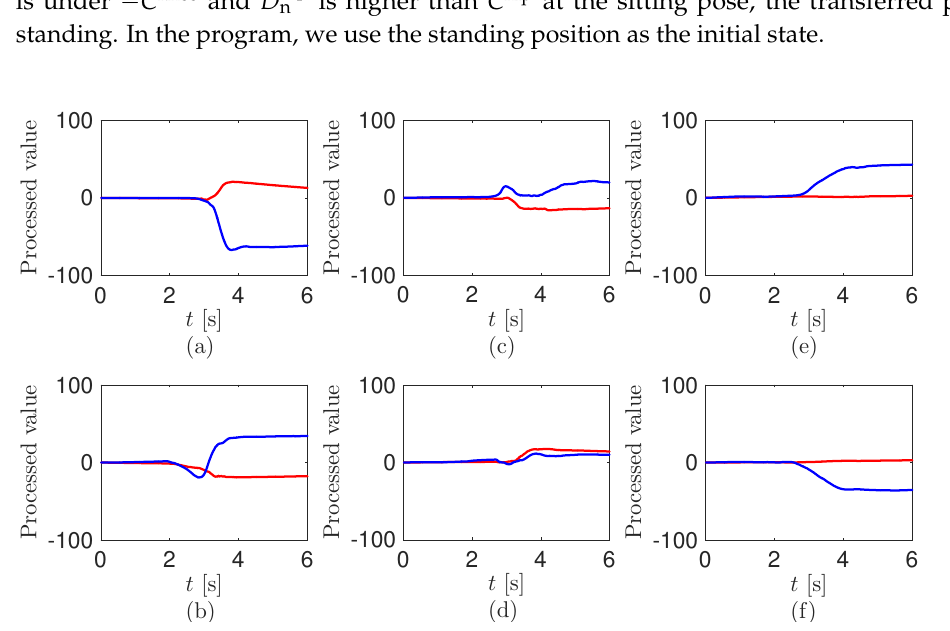
Figure 6. Signal processed values from the sensor outputs at the transition ( a ) from the standing to sitting position; ( b ) from the sitting to standing position; ( c ) from the sitting to sitting knee extension position; ( d ) from the sitting knee extension to sitting position; ( e ) from the sitting knee extension to supine position; and ( f ) from the supine to sitting knee extension position. The red and blue lines are the data of the sensor at the knee and hip, respectively.